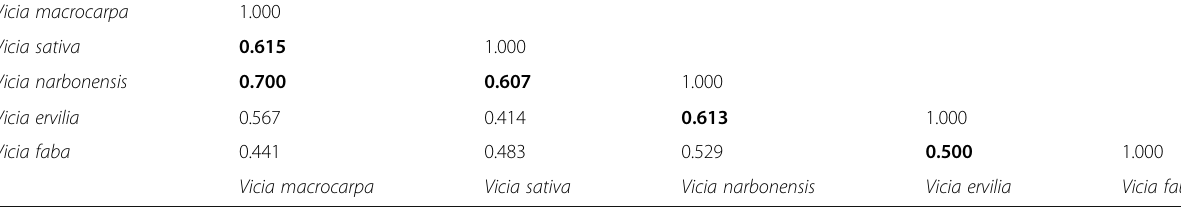
Table 3 The level of similarities among Vicia species, produced by Jaccard ̍ ’ s coefficient, based on water non-soluble proteins